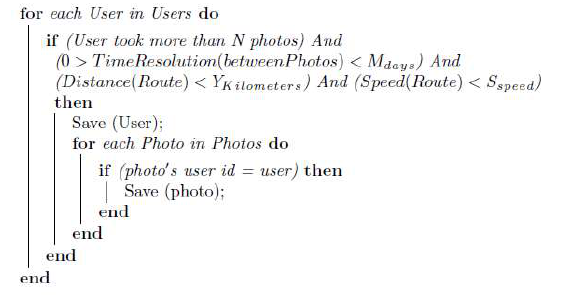
Figure 1. Pseudo-code for identifying tourism